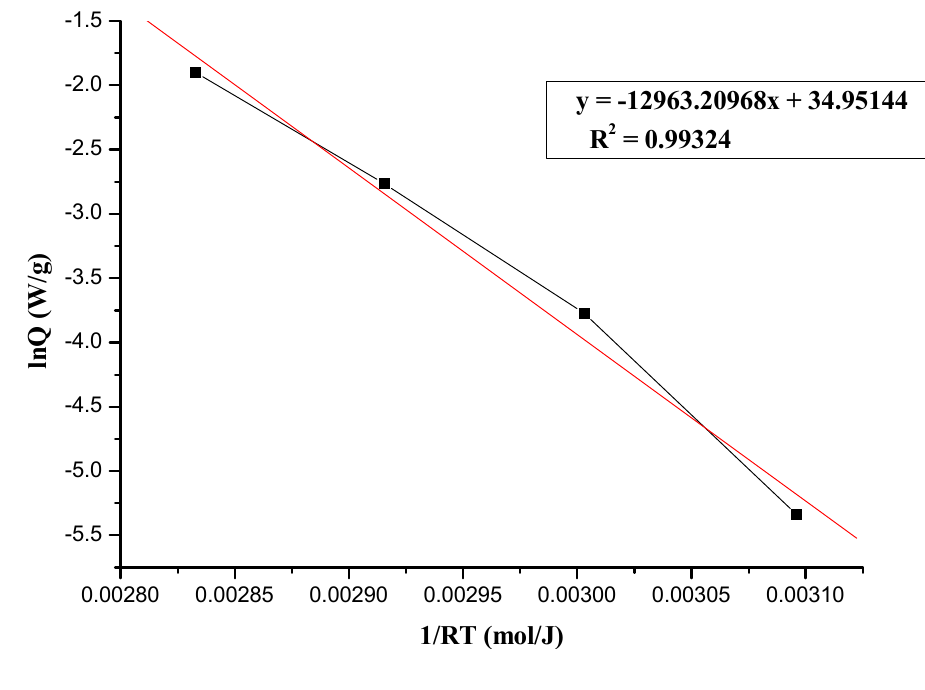
Figure 5. Determination of activation energy from the slope of lnQ vs. 1/(RT) for the thermal decomposition of 95 mass% LPO with 12 N HNO TAM III